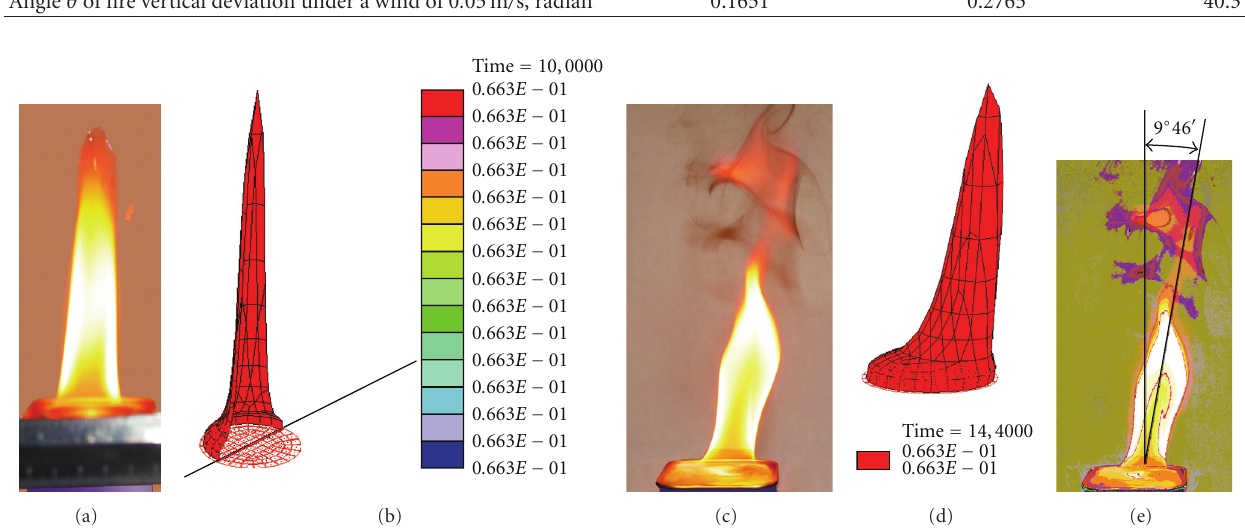
Figure 1: Example simulation of an isooctane pool fire. (a) a photograph of fire without wind; (b) the isosurface of relative mass fractions of isooctane vapors, corresponding to the highest-rate reaction in the air-and-fuel mixture combusting without wind (stoichiometric mass fraction); (c), (d), and (e) are combustion with a side wind having a speed of 0.05